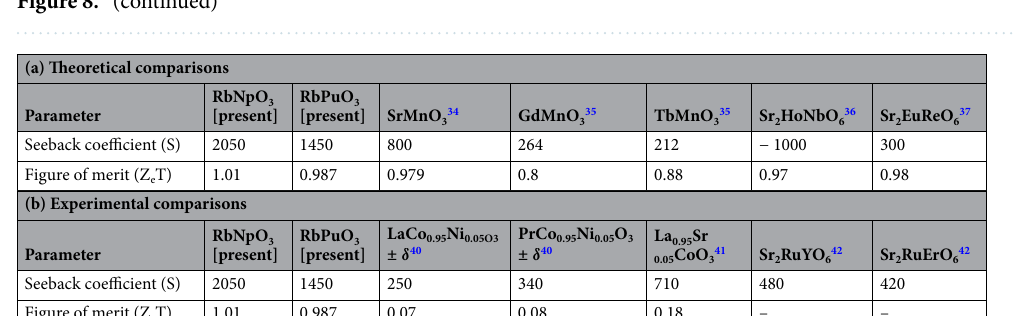
Table 3. Calculated values of Seeback coefficient (S) and Figure of merit (Z e T) for present study in comparison with (a) theoretical and (b) experimental results available in the